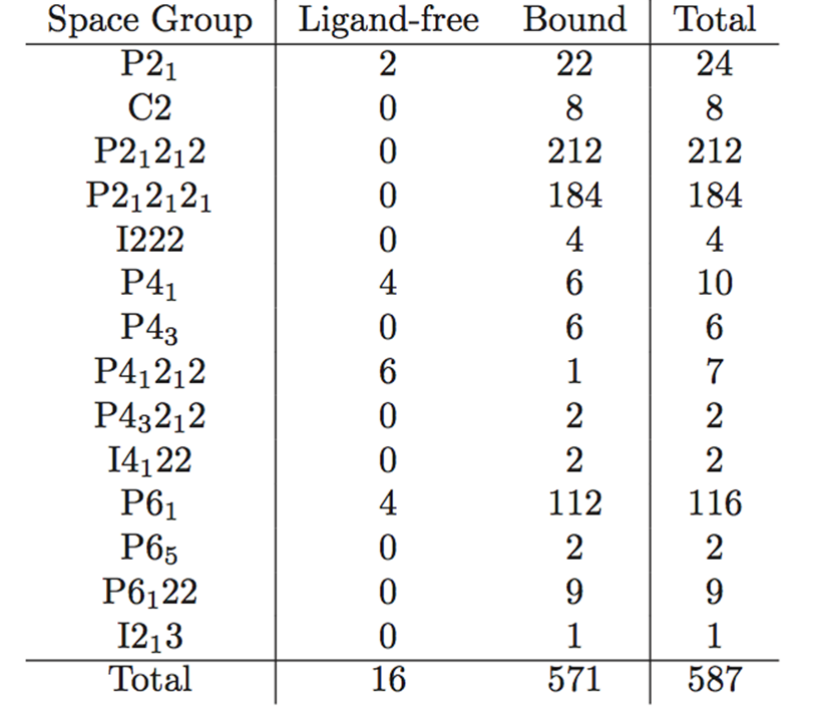
Table 4. Distribution of PR structures by space group. In the strictest sense, the distribution should be further subdivided because not all structures belonging to the same space group have isomorphous unit